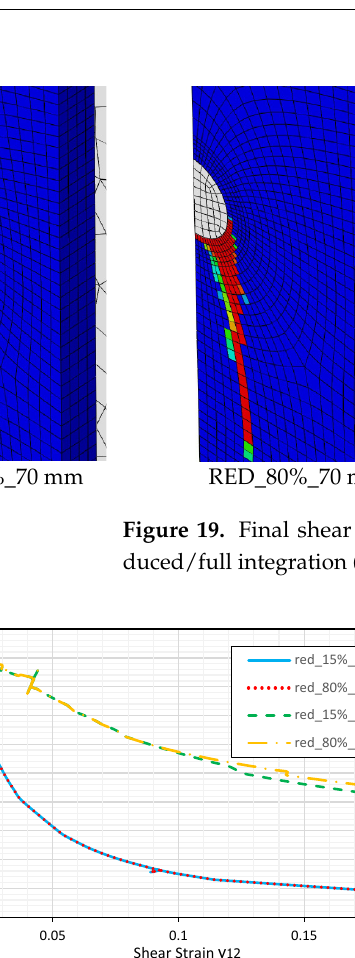
Figure 20. Values in the bolt opening at 30 ᵒ for 15 mm and 70 mm of cover with reduced integration: rectly. This is also the case for the shear damage evolution displayed in Figure 20b. ( a ) Shear stress vs. shear strain; ( b ) shear damage vs. shear strain cover for the double-lap test.